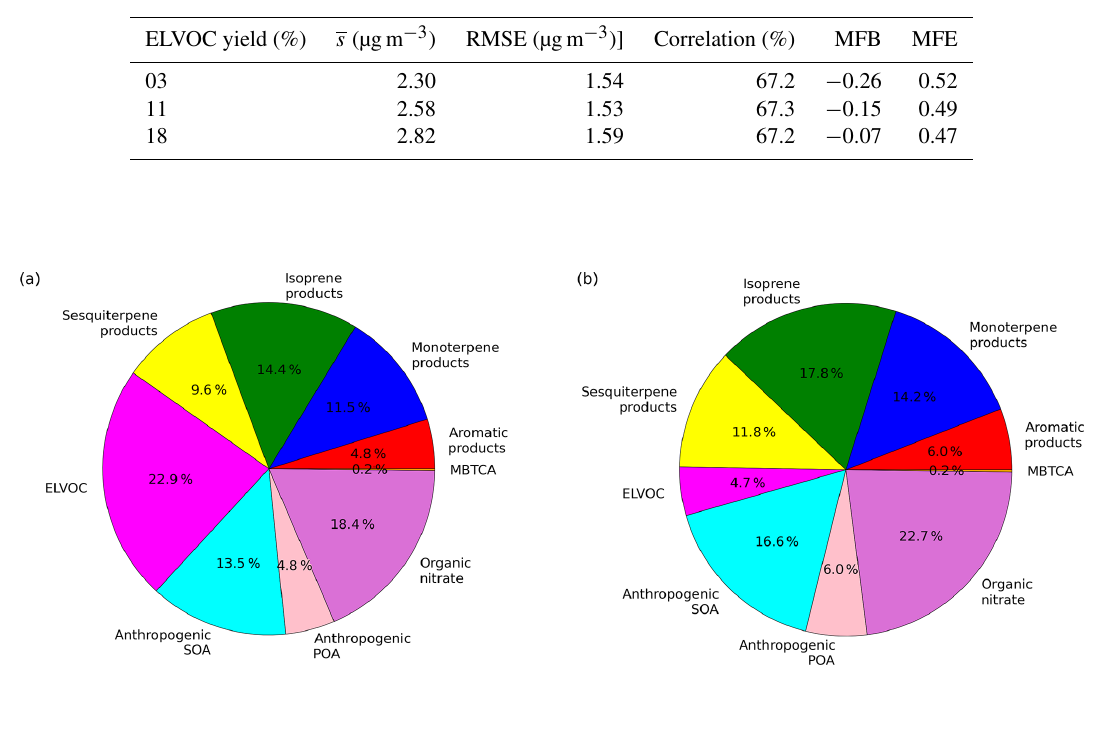
Table D1. Statistics of model to measurements comparisons for organic concentrations in particles of diameters lower than 1µm during the summer campaign of 2013 using an ELVOC molar yield of 3, 11 (reference) and 18%. s represents the simulated mean concentrations. The observed mean concentration is o = 2 . 89µgm − 3 .